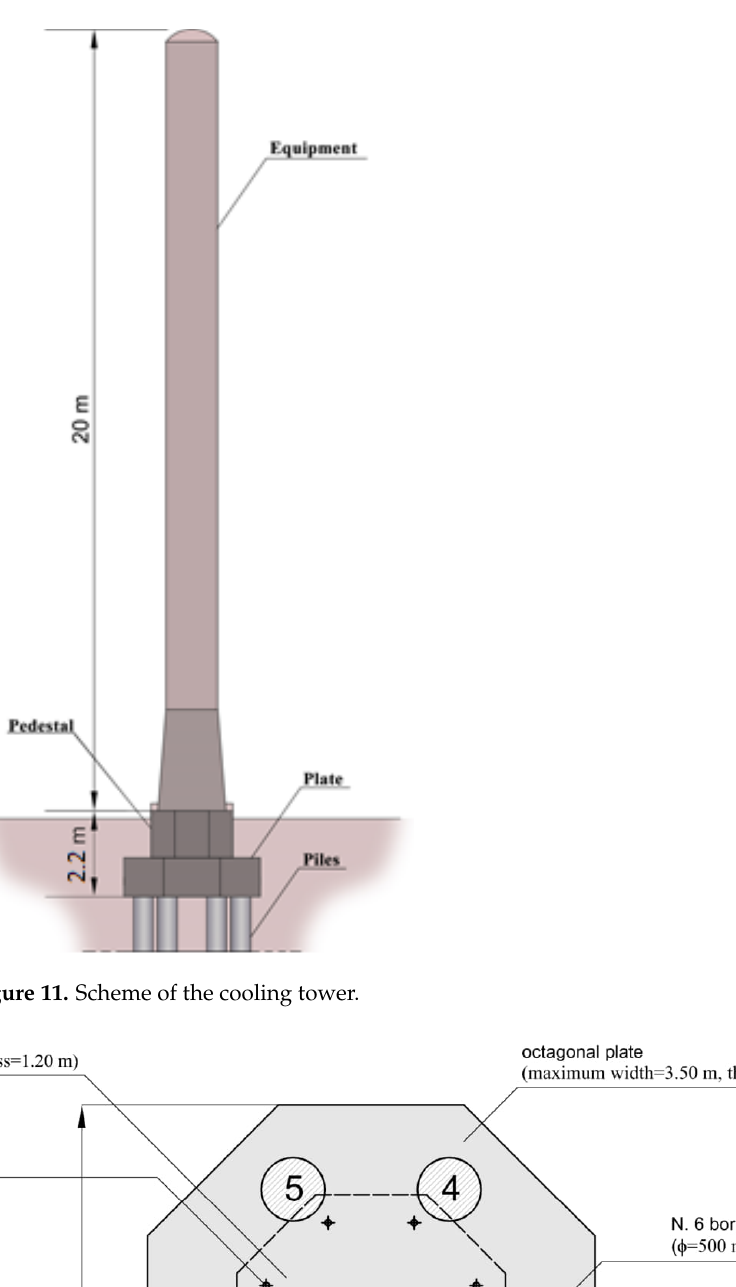
Figure 12. Plan view of the basement.